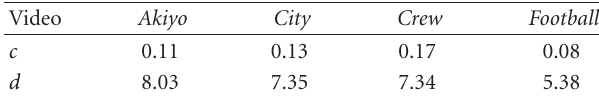
Table 2: Quality parameter values c , d for standard videos.